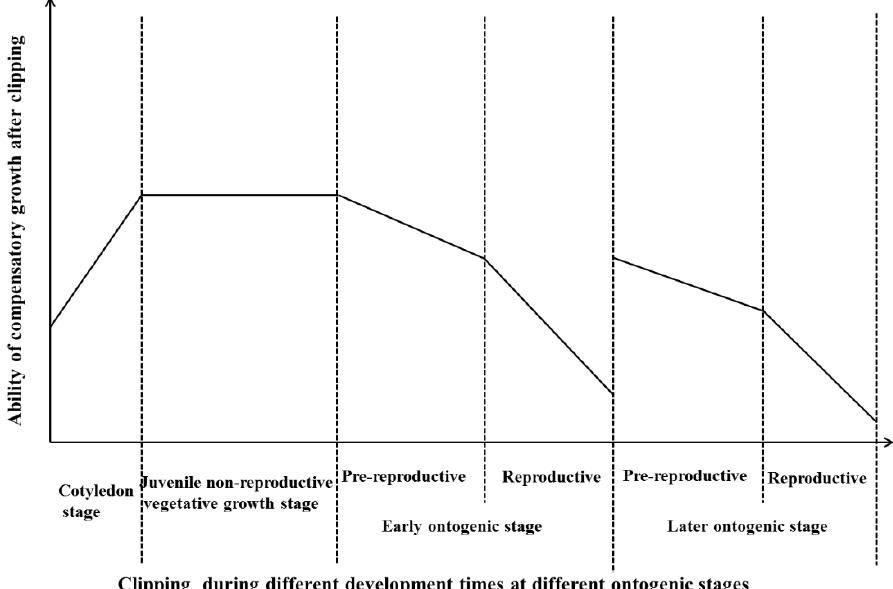
Figure 7. Generalized response diagram of the ability of compensatory growth after clipping during different development times at different ontogenic stages for perennial herbs (synthesized and referred from Boege and Marquis 2005, Hanley and Fegan 2007, Tito et al. 2016, and from this research).